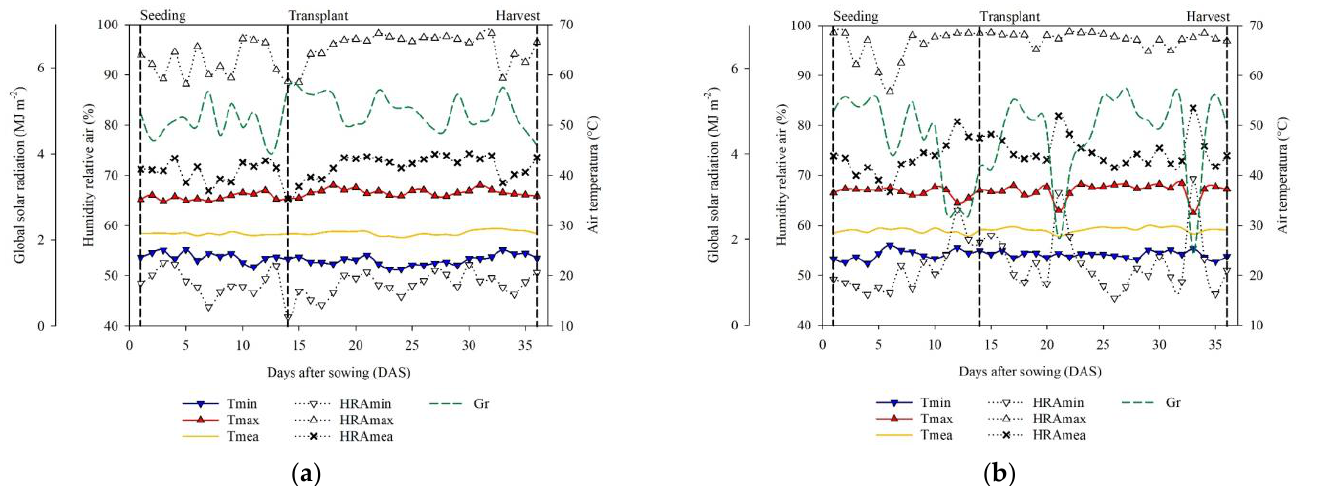
Figure 1. Values of relative humidity (%) and temperature (°C) of air and global solar radiation (MJ m − 2 ) within protected environment between November 2019 and March 2020. First result with NaCl ( a ) and second cycle — CaCl 2 ·2H 2 O ( b ).